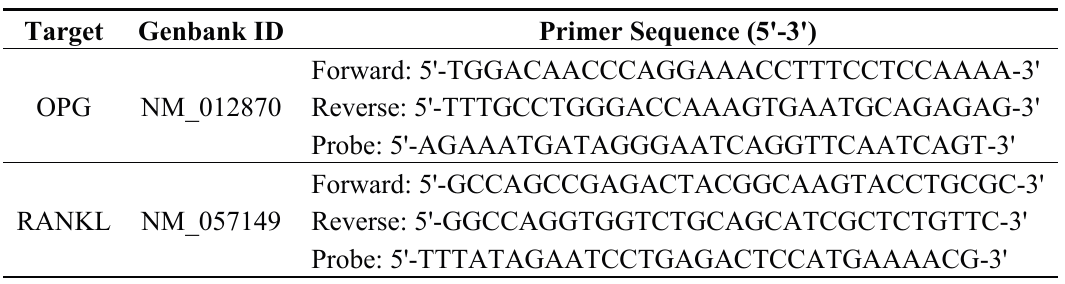
Table 3. The primer sequence used in the experiments (BORSTER, Wuhan,